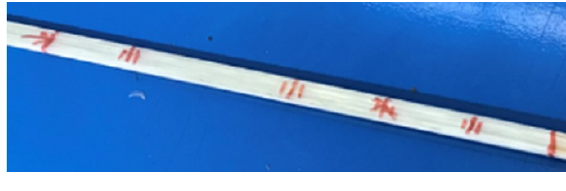
Figure 5. Sensorized FRP beam test piece.